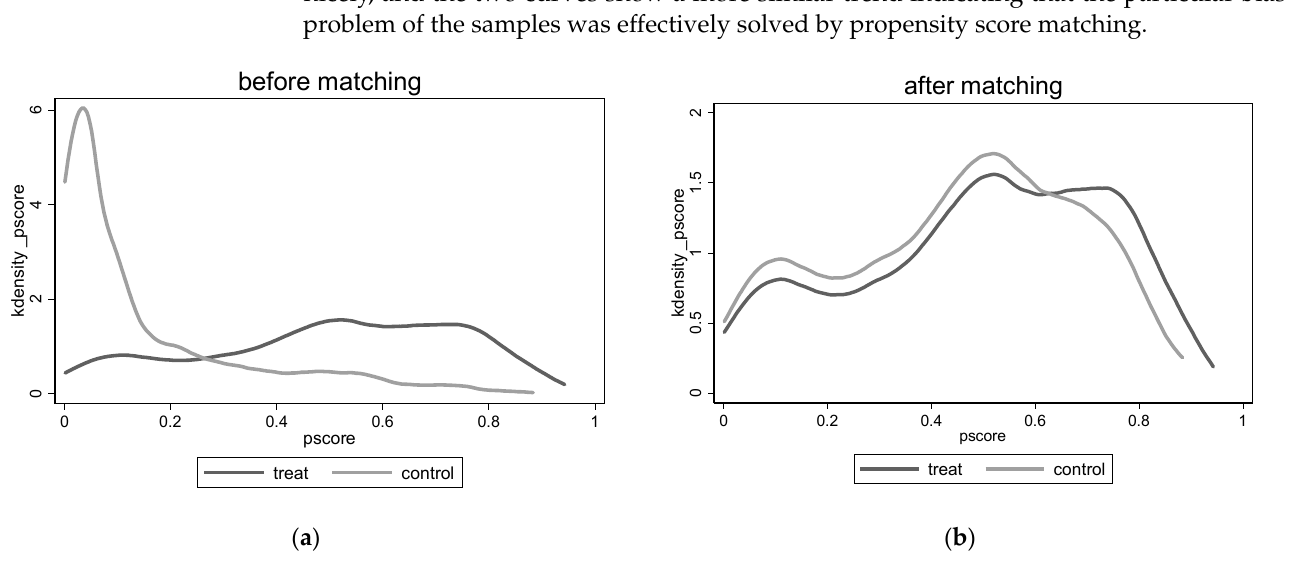
Figure 1. Kernel density maps: ( a ) before matching; ( b ) after matching.